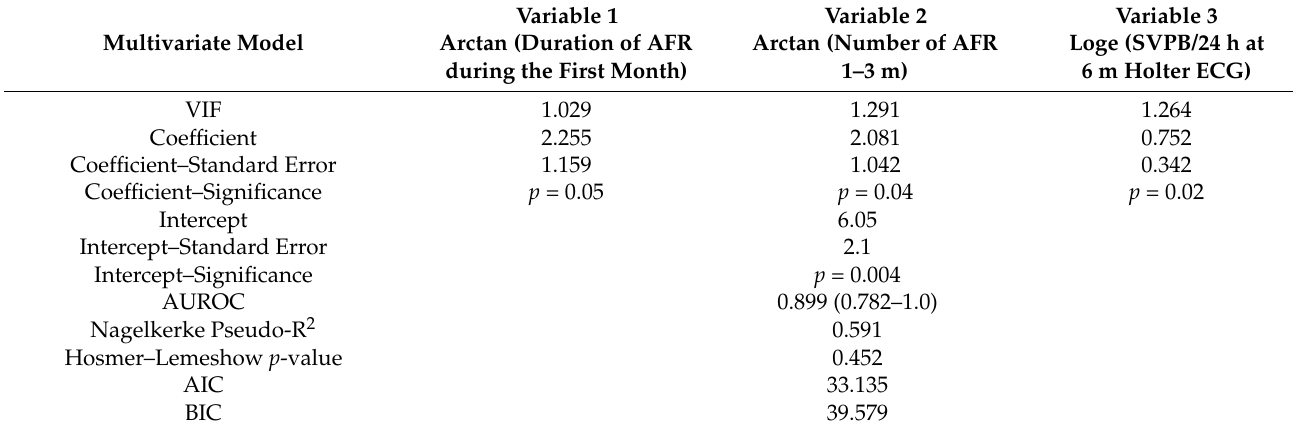
Table A4. Multivariate Model Information: statistical characteristics of 6-month SCORE (for late AFR 6–12 months).